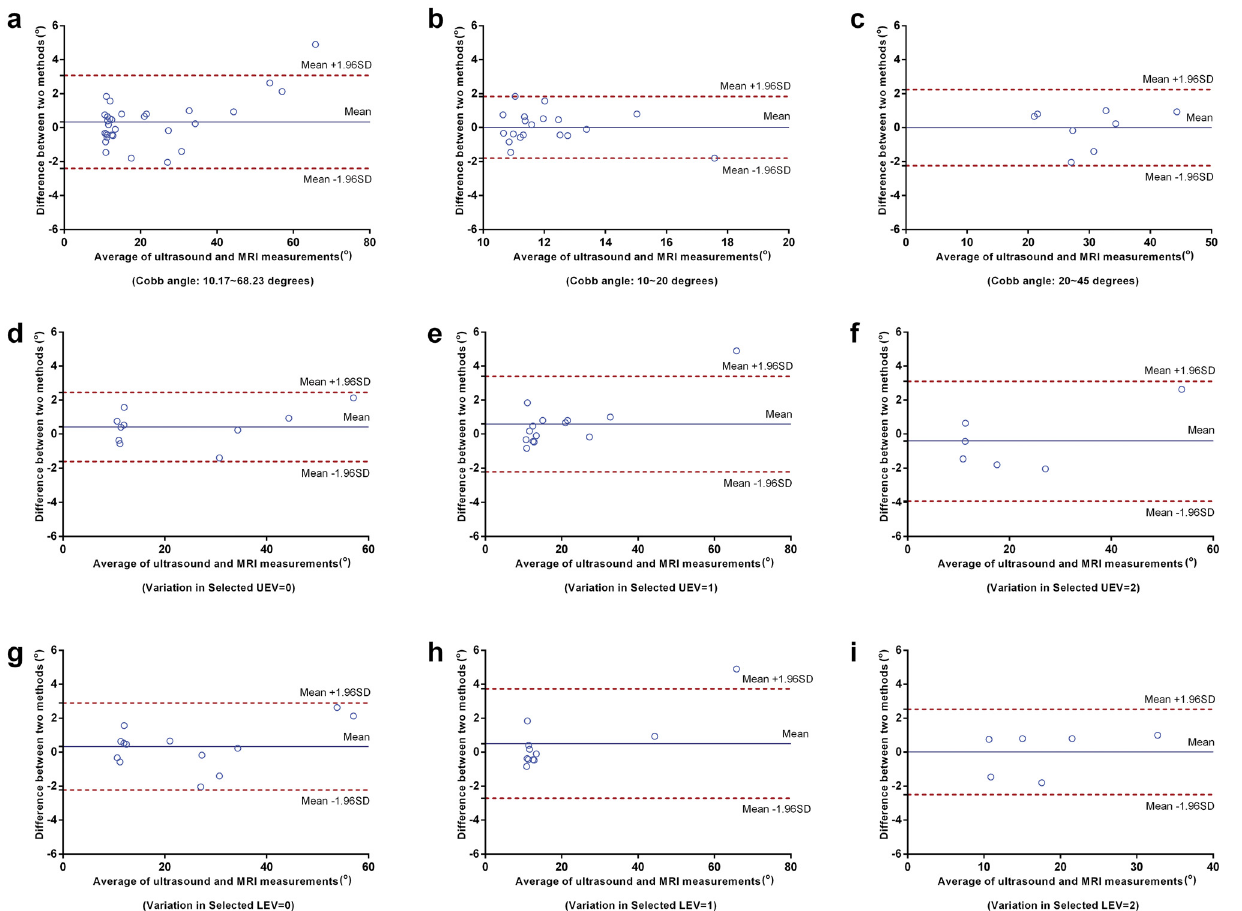
Fig 5. Bland – Altman plot assessing the agreement of coronal curvature measurements using ultrasound and MRI in the sample categories. (a) Cobb angle: 10.2°~68.2°; (b) Cobb angle: 10.0°~20.0°; (c) Cobb angle: 20.0°~45.0°; (d) Variation in selected UEV = 0; (e) Variation in selected UEV = 1; (f) Variation in selected UEV = 2; (g) Variation in selected LEV = 0; (h) Variation in selected LEV = 1; (i) Variation in selected LEV = 2. The central line represents mean differences (Bias); upper line shows mean+1.96SD and lower line mean-1.96SD. UEV: upper-end vertebra; LEV: lower-end